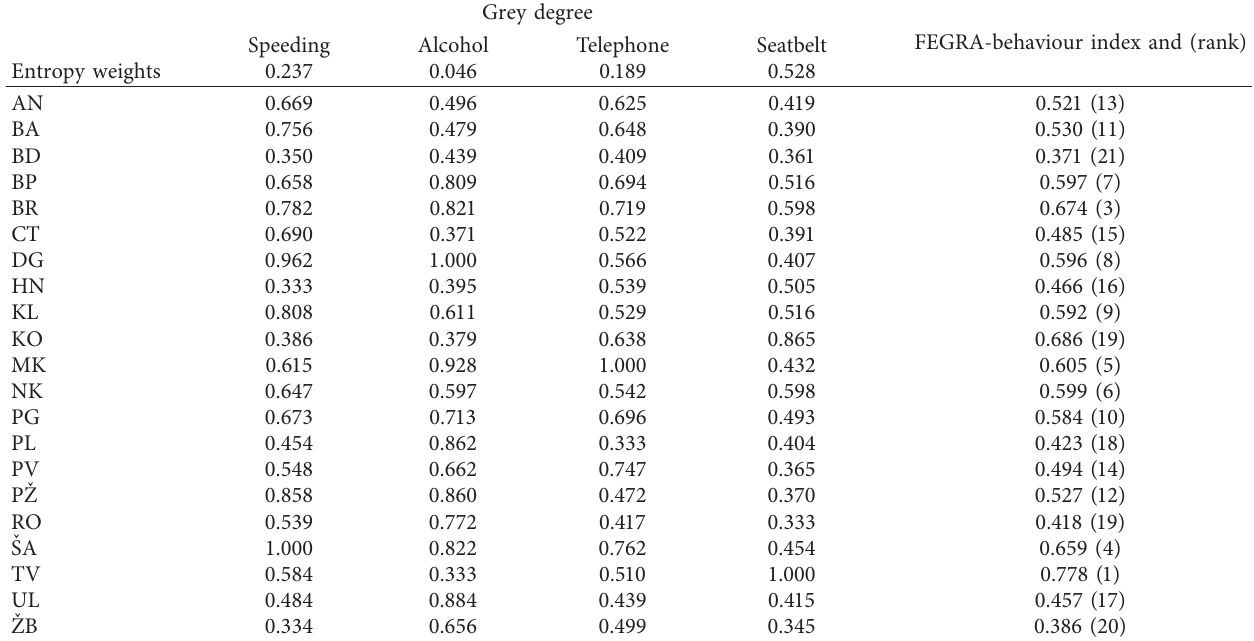
Table 8: Final behavior index and rank.